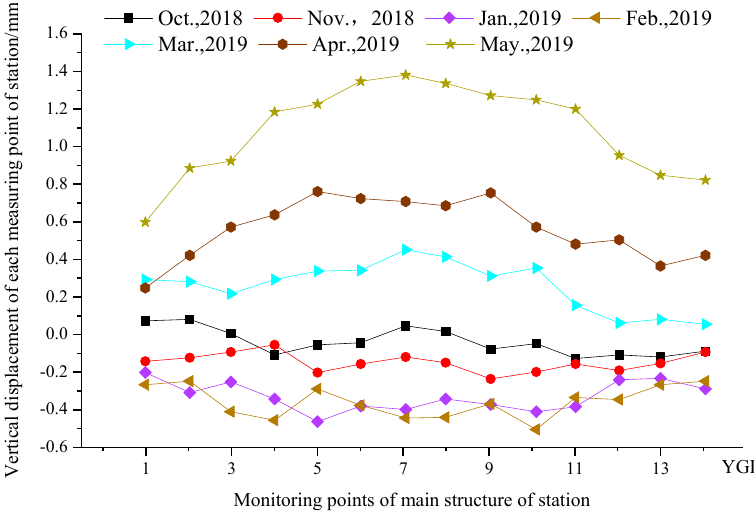
Figure 8. Vertical displacement time − history curve of each measuring point of the station.